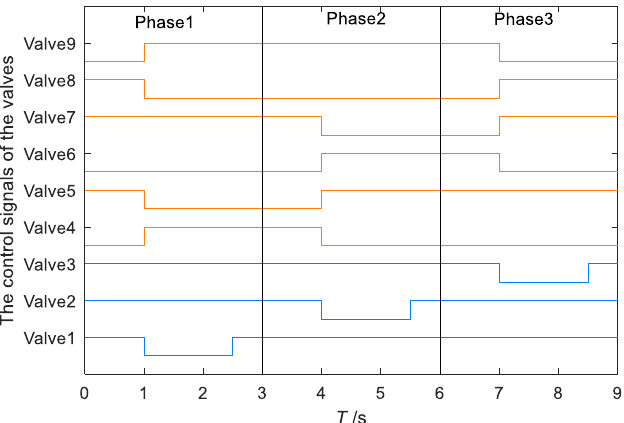
Figure 7. The solenoid valves’ control signal during the motion cycle of the robot. As shown in Figure 4, valves 1–3 control the pressure in suction cups, and valves 4–9 control the pressure in the cylinders of segments 1–3. If the solenoid valve receives high potential, the cylinder will be connected to the air pump, and if it’s low potential, the cylinder will be connected to the